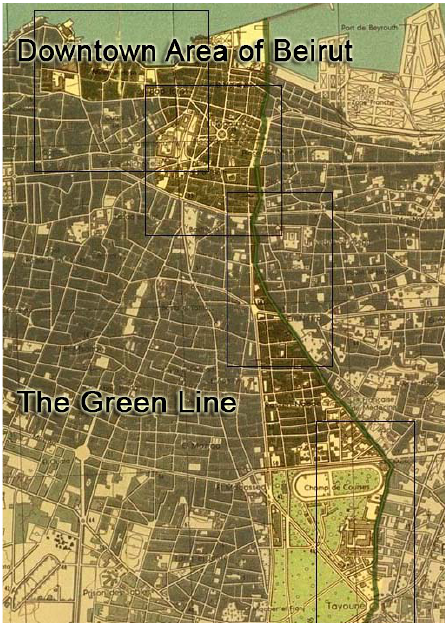
Figure 1. The green line is the separation line that is still virtually dividing Beirut’s areas in people’s memory. It is green since plants grew when the inhabitants fled due to the severe battles that occurred there. This line passed by the downtown (picture from Habib et al. , annotation from Yazigi